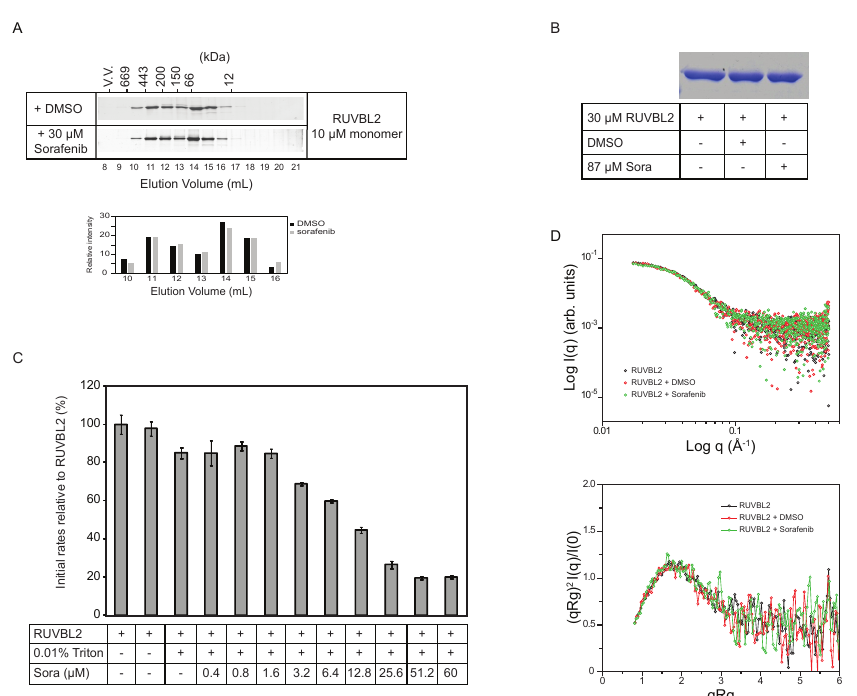
Figure 2. E ff ect of sorafenib on RUVBL2 oligomerization and aggregation. ( A ) 10 µ M RUVBL2 was incubated with DMSO or 30 µ M sorafenib and then loaded onto gel filtration column (Superdex 200) at 4 ◦ C. 1 mL fractions were collected, and proteins were visualized on SDS-PAGE gel by silver staining. Proteins were incubated with DMSO or sorafenib for 30 min on ice prior to loading on the column. The positions of the molecular mass standards in kilodaltons are given along the upper x-axis. The bar graph below the gels shows the quantifications of the bands in elution volumes 10 to 16 mL. ( B ) SDS-PAGE gel showing RUVBL2 alone, with DMSO or with sorafenib. 30 µ M RUVBL2 was incubated with DMSO or with 87 µ M sorafenib on ice for 30 min. Samples were spun down and then supernatants were loaded on the gel. Gel image shows that sorafenib does not cause aggregation of RUVBL2 at the tested concentrations. ( C ) ATPase activity of RUVBL2 (10 µ M protomer concentration) with increasing concentrations of sorafenib in the presence of 0.01% Triton. Bar graph shows decreasing activity of RUVBL2 with increasing concentration of sorafenib even in presence of Triton which should prevent protein aggregation. ( D ) Small angle X-ray scattering data of human RUVBL2. Scattering profiles (upper panel) and dimensionless Kratky plot (lower panel) of apo RUVBL2, RUVBL2 + DMSO and RUVBL2 + sorafenib. The overlap of the curves suggests that, overall, sorafenib does not induce significant structural changes in RUVBL2 nor a ff ects the protein’s oligomeric